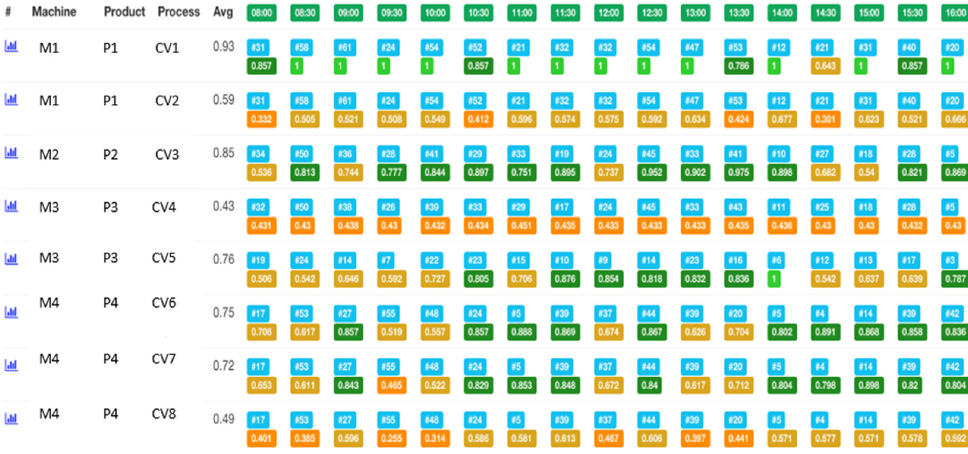
Figure 12. Web-based GUI for predicting PQP in real-world manufacturing process.